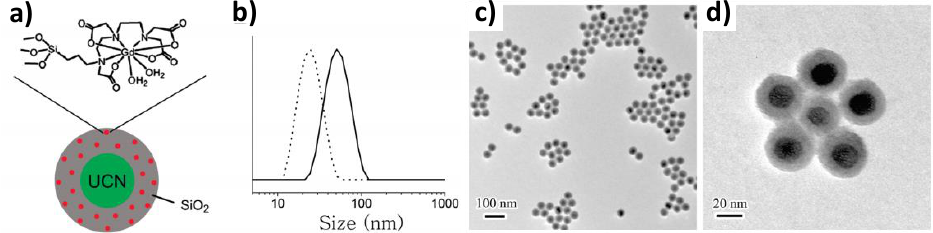
Figure 20. (a) Schematic illustration of single NaYF 4 @Si-DTTA-Gd 3+ NPs. (b) DLS data of NaYF 4 NPs before (dashed line) and after Si-DTTA-Gd 3+ coating (solid line). (c,d) TEM images of NaYF 4 @Si-DTTA-Gd 3+ NPs at different magnification. Reproduced from [19], with permission from ACS Publisher, 2009.